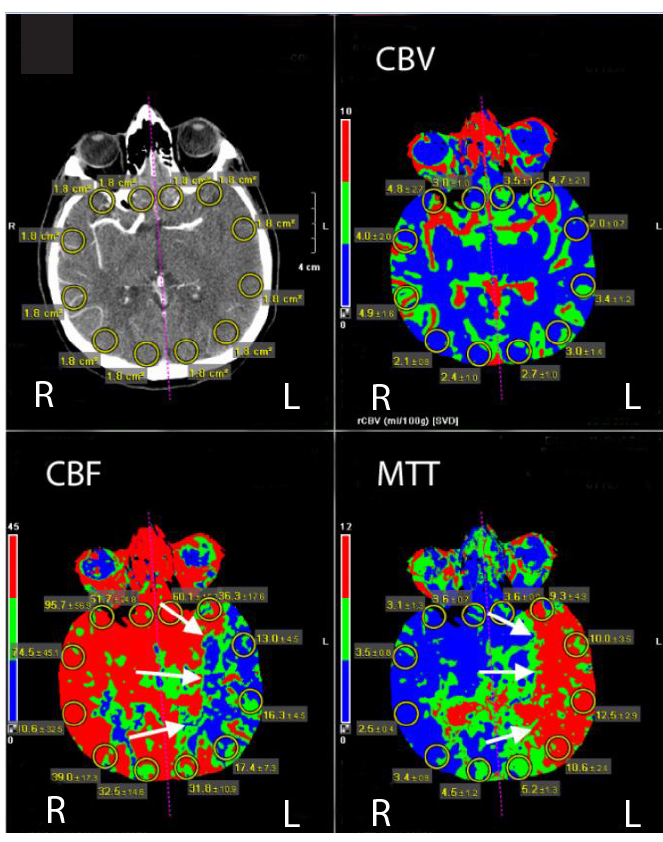
Figure 2. Computer-generated perfusion map demonstrating the region of the left cerebral hemisphere (CBF) with decreased cerebral blood flow and prolonged mean transit time (MTT) (marked by arrows). Note that this region of the brain has normal cerebral blood volume (CBV) indicating potentially salvageable brain